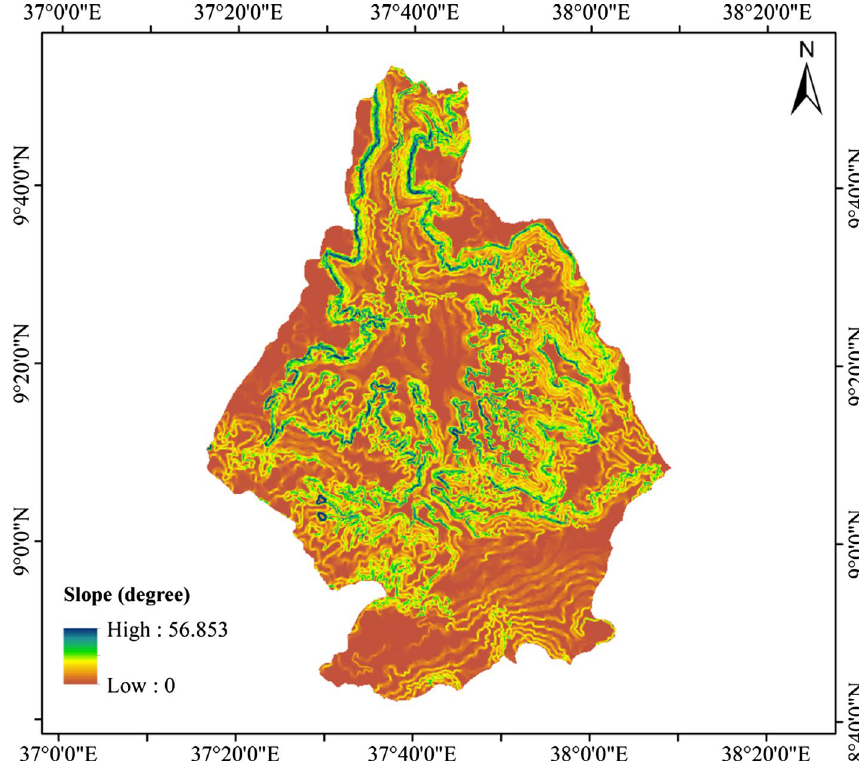
Fig. 2 The slope of Guder